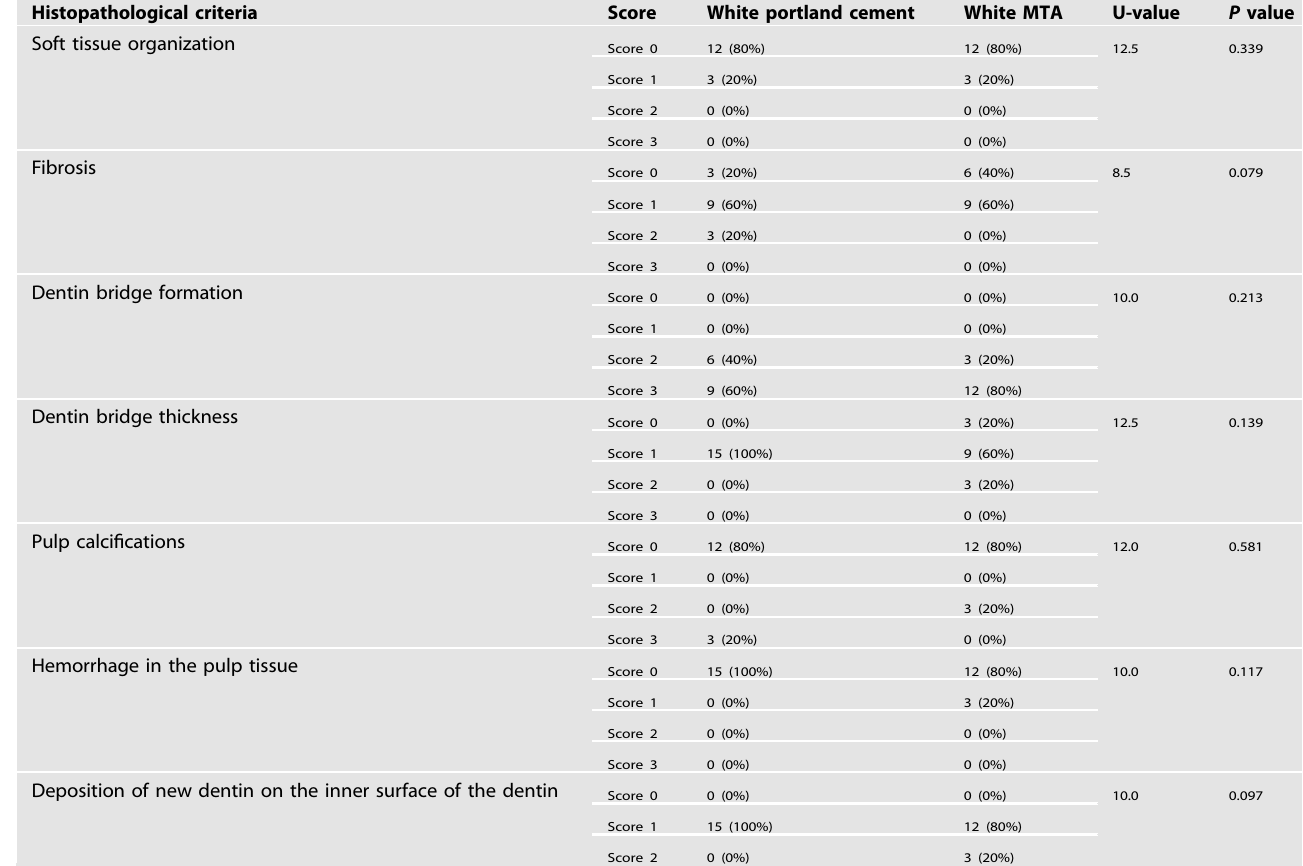
Table. 1. Results of histopathological